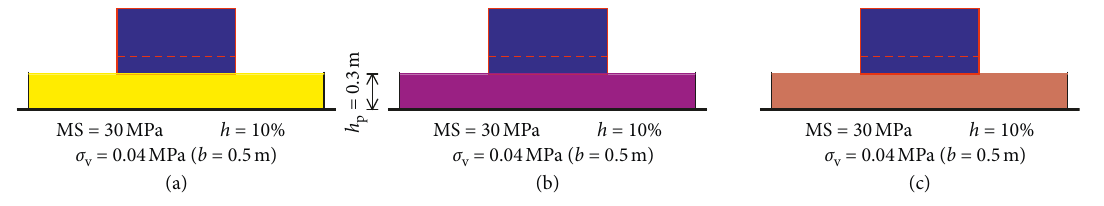
Figure 3: Analysed pebble fractions. (a) Φ